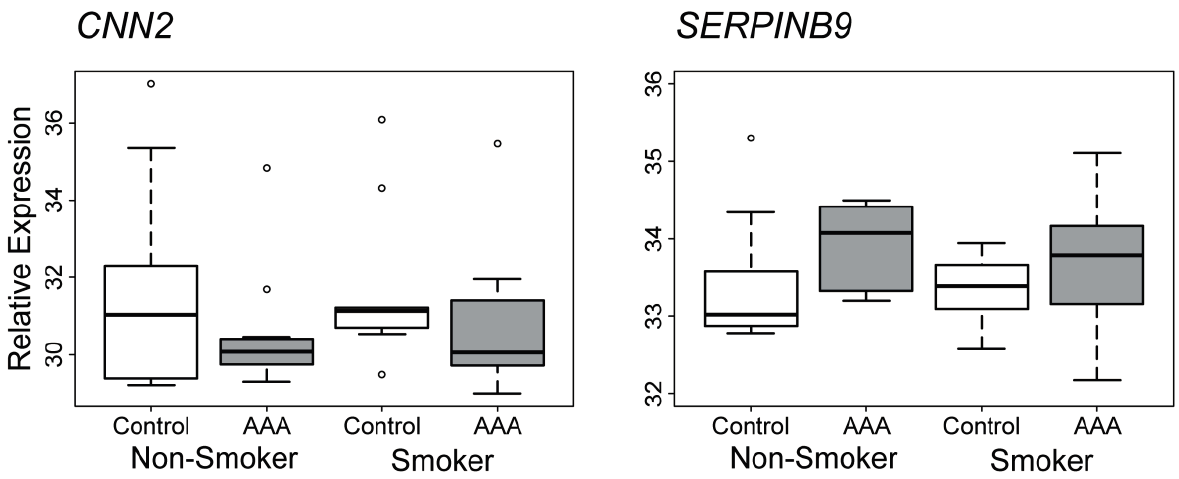
Figure 2. Comparison of CNN2 and SERPINB9 mRNA levels in PBMC of AAA smokers ( n = 14), AAA non-smokers ( n = 12), control smokers ( n = 10) and control non-smokers ( n = 10). The C t difference was calculated by subtracting the C t value of the RPL gene (housekeeping gene) from the C t value of CNN2 (or SERPINB9 ) for each sample. The difference was then subtracted from the value 40 (highest cycle count) to obtain values in which larger value means higher expression and lower value means lower expression level.